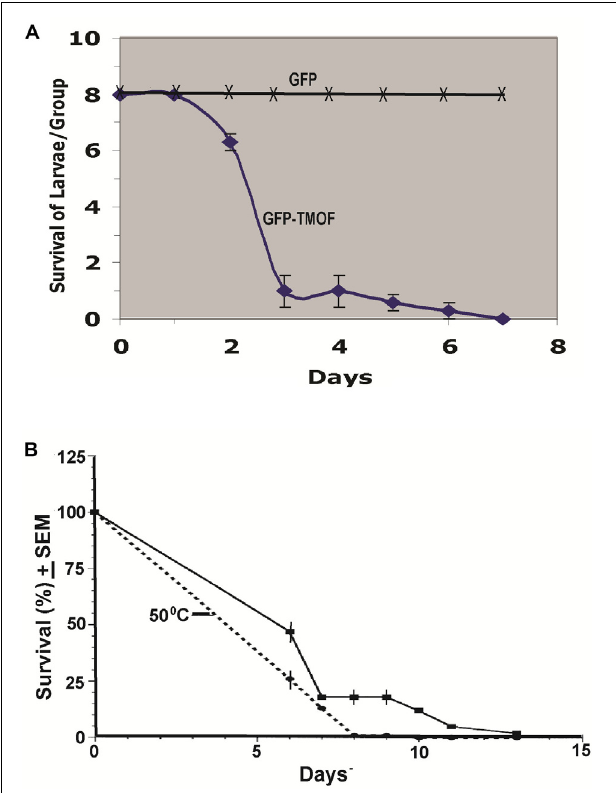
FIGURE 8 | (A) Feeding first instar Ae. aegypti larvae KM71- gfp-tmf A and KM71H- gfp (control) cells after shake flask fermentation and heat treatment (80 ◦ C for 3 h). Three groups (8 larvae per group) were fed the engineered cells (2 × 10 7 cells) in 48 well plate containing one larva in 1 ml water per well for 7 days. (B) Comparison between KM71- tmf A cells that were heated at 55 ◦ C for 3 h (broken line) and cells that were not heated (solid line) and were fed to 6 groups of 100 larvae per 200 ml for 13 days. Mortalities were followed daily and the results are expressed as means ± SEM.